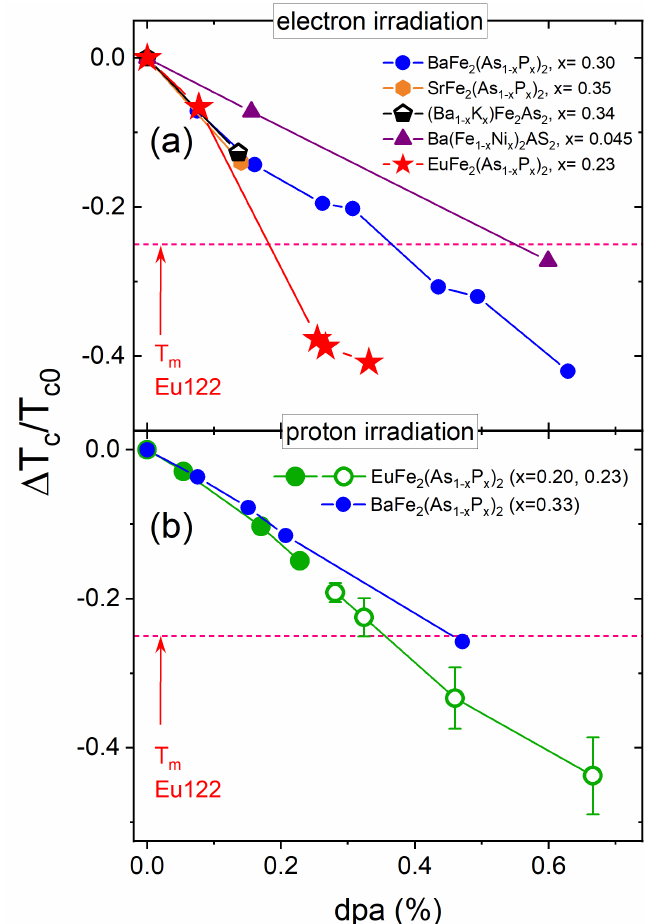
Figure 9. The normalized rate of T c suppression by electron irradiation (panel ( a )) and proton irradiation (panel ( b )). Electron irradiation results from this work are compared to the data in other compounds, summarized in Ref. [59]. The data for the important for direct comparison BaFe 2 ( As 1 − x P x ) 2 are from Ref. [63]. The dpa percentages were calculated for each of the